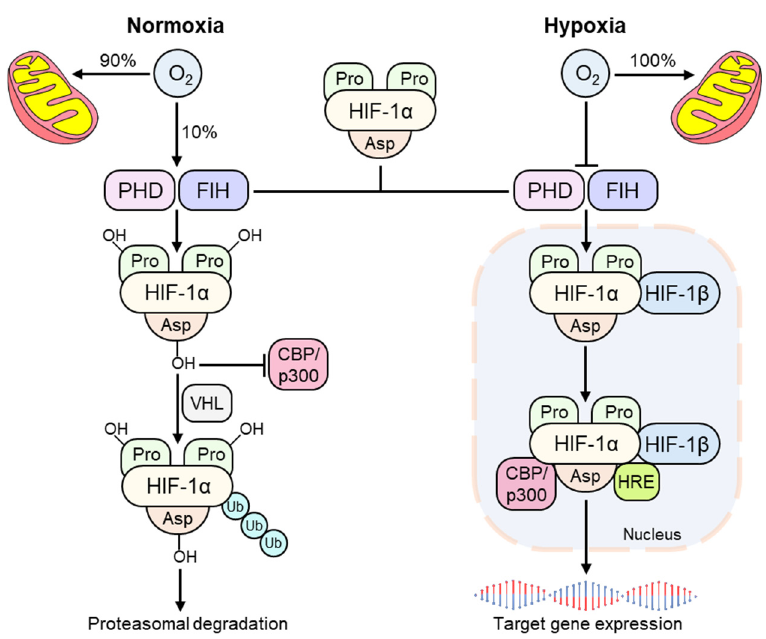
Figure 2. The hypoxia-inducible factor (HIF) pathway. In normoxia, most O 2 is consumed by the mitochondria and remaining O 2 facilitates hydroxylation of HIF by PHDs and FIH, leading to ubiquitin attachment by VHL E3 ubiquitin ligase. This results in proteasomal degradation and transcriptional repression of HIF. In hypoxia, virtually all O 2 is used by the mitochondria resulting in hydroxylase inhibition. Stabilized HIF- α dimerizes with HIF-1 β thereby forming a heterodimeric complex which binds to HRE and CBP/p300, leading to increased transcriptional expression of HIF-dependent genes.